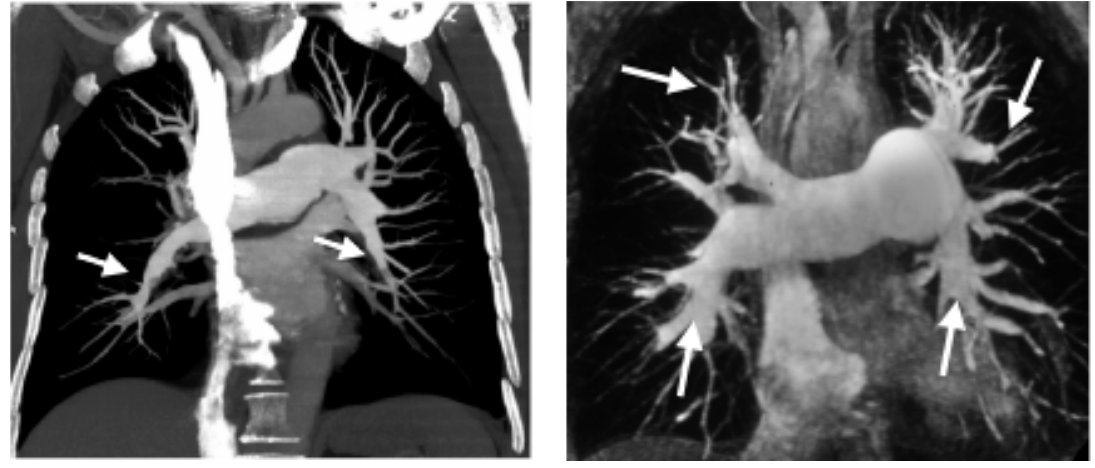
The distribution of obstructive pulmonary artery lesions at the main, lobar and segmental levels is detected by CT scanning.